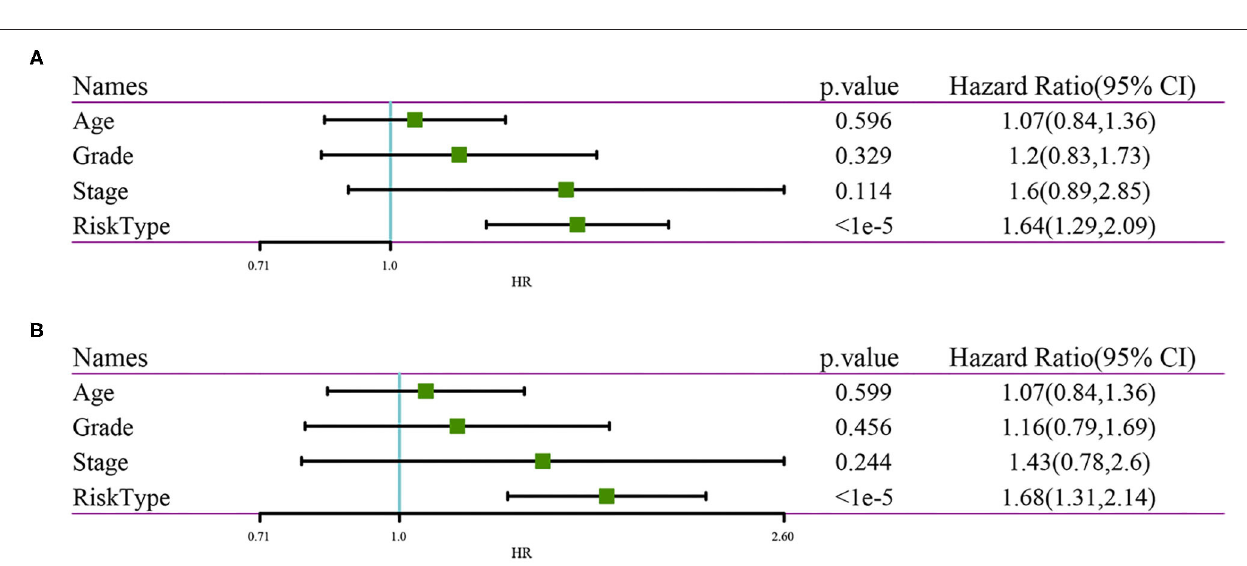
Pyruvic acid is an intermediate metabolite of the tricarboxylic acid cycle and provides the precursor citrate for fat formation, including the biosynthesis of cholesterol and free fatty